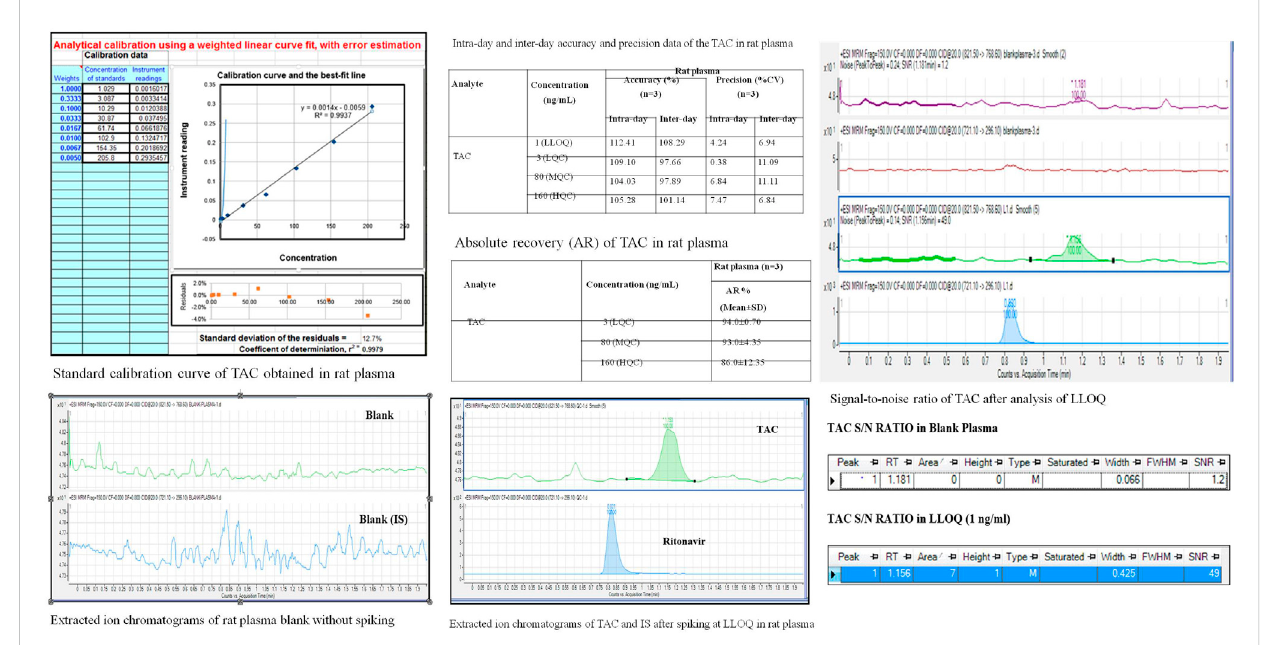
FIGURE 3 Method validation of TAC on LC-MS/MS instrument estimating QC samples, 2A; LLOQ, speci fi city; 2B,